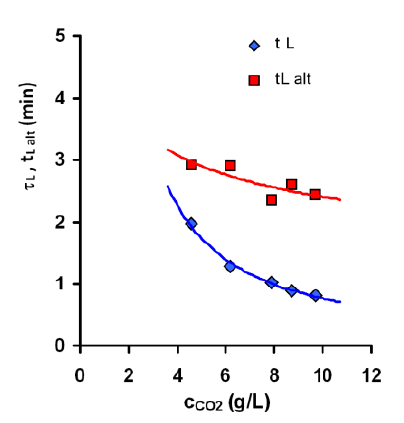
Fig. 12. Liquid formation – effect of CO 2 content: parameters  L and t L alt .